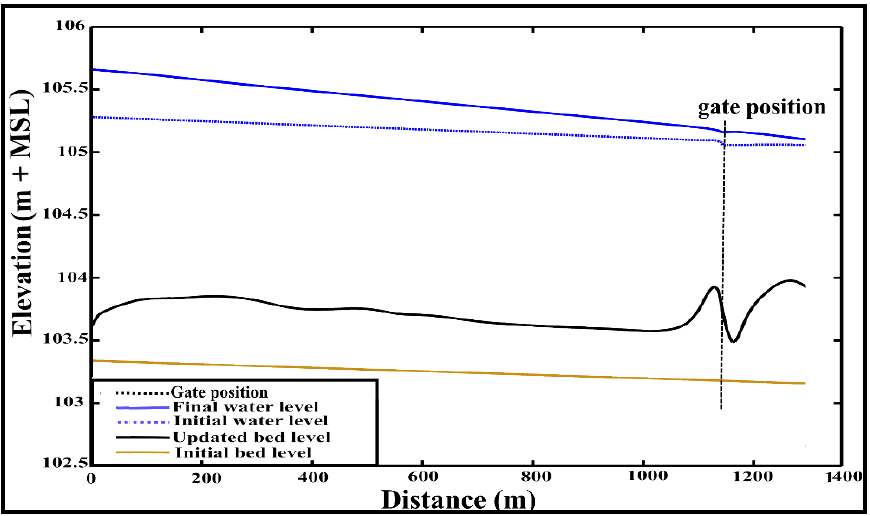
Figure 8. Bed level and water level updating in the main canal without the settling basin.